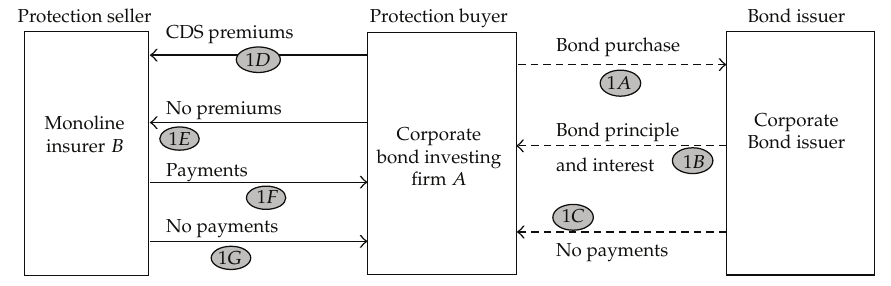
Figure 1: The structure of